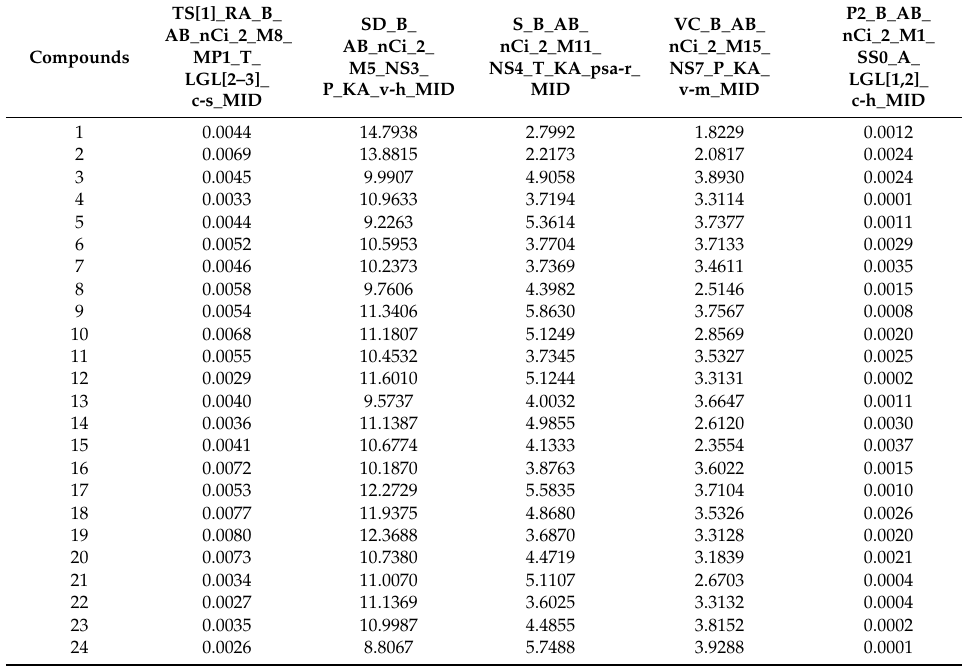
Table 2. Five of the most important molecular descriptors involved in the activity against Staphilococcus aureus , SA-1199B strain.